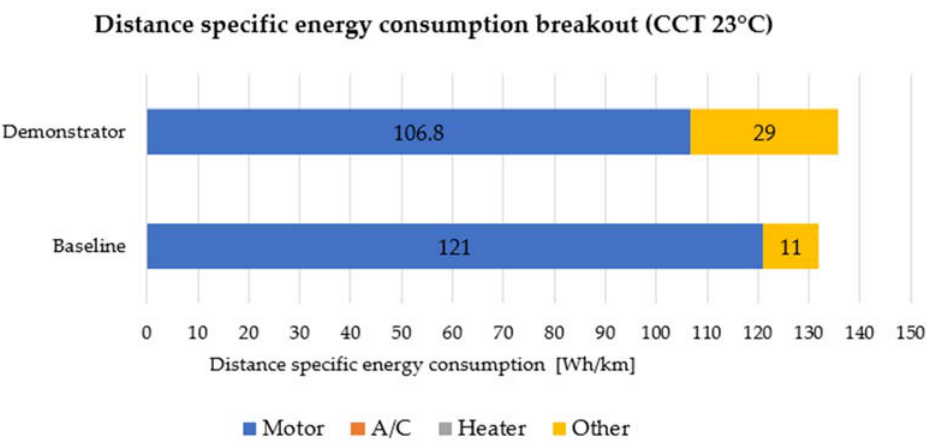
Figure 8. Distance specific energy consumption (CCT at 23 ◦ C) of the demonstrator and baseline vehicles. Table 4 . Energy consumption results for the WLTP CCT at 23 °C for the baseline [14] and the de ‐ monstrator vehicle. Results for the two measurement cases (Case 1—CAN current and CAN voltage measurements; Case 2—AC/DC clamp for current and CAN voltage measurements) .